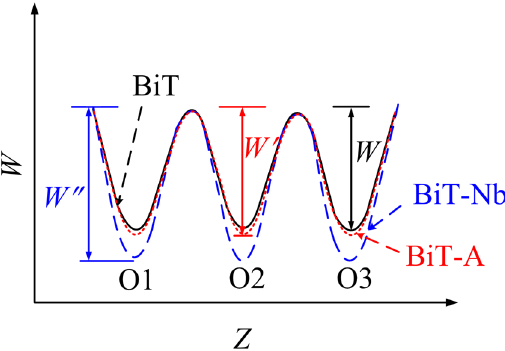
Figure 13. Schematic potential well systems for the jump of oxygen vacancy inside BiT, BiT-A, and